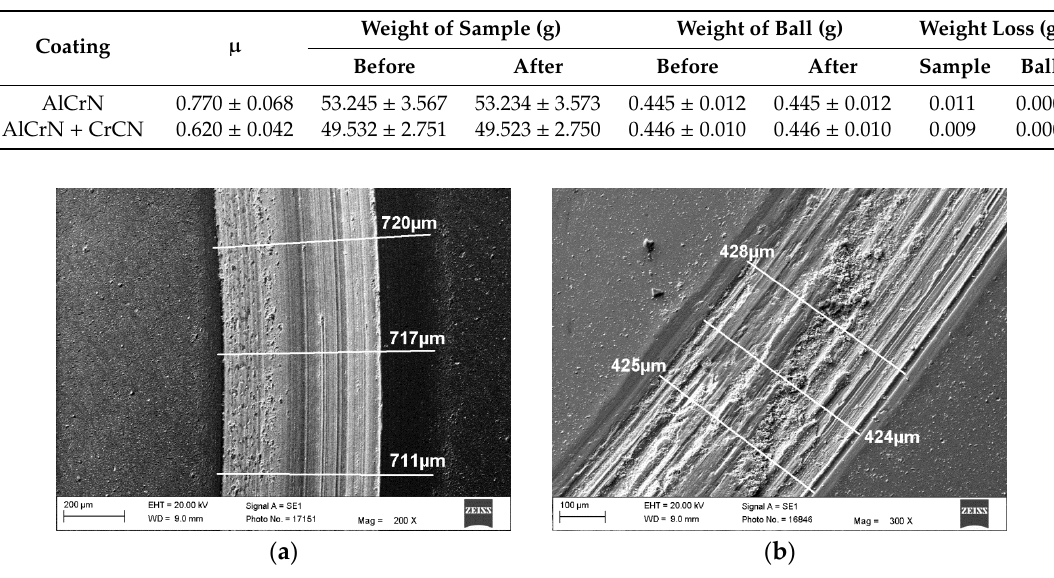
Table 3. The average value of the friction coe ffi cient and the weight loss of tested coatings.